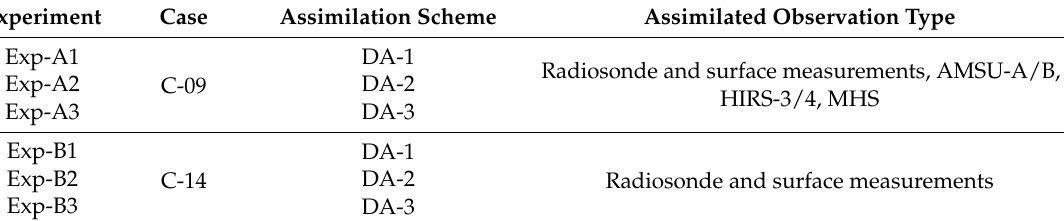
Table 4. Design of